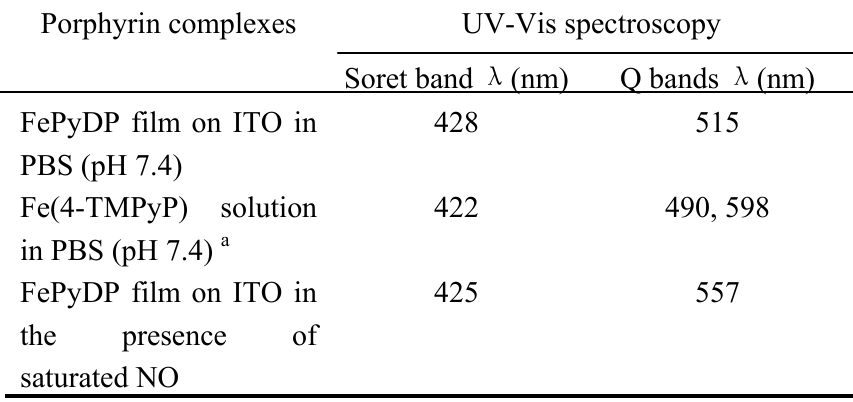
Table 1. Spectrophotometric characteristics of Fe(4-TMPyP) in various systems.